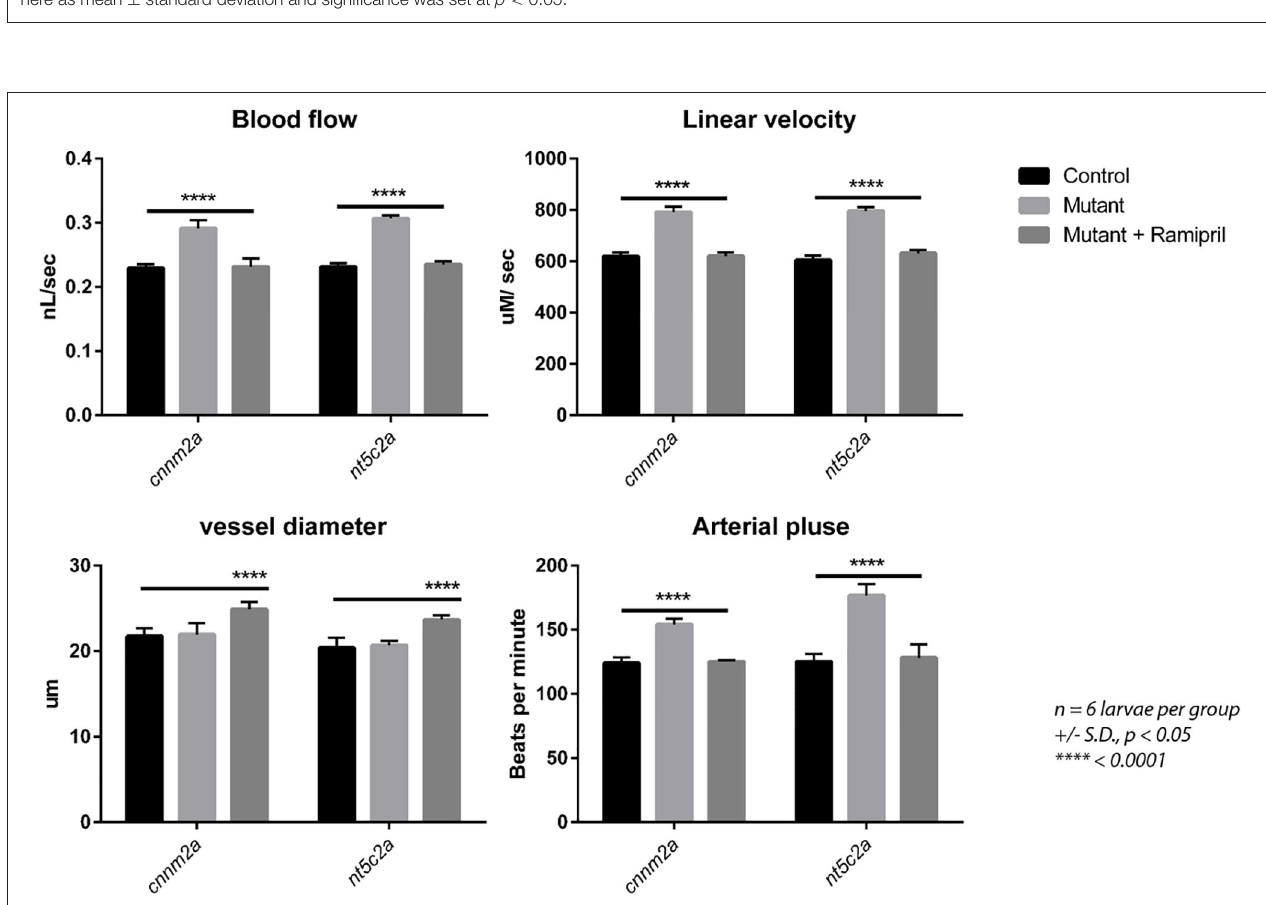
FIGURE 6 | Blood flow parameters measured with and without Ramipril treatments from cnnm2a and nt5c2a mutant zebrafish larvae along with ab-wildtypes as control. Blood flow (nL/sec), arterial pulse (beats per minute), vessel diameter ( µ m) and linear velocity ( µ M/sec) were measured from n = 6 larvae per group and presented here as mean with standard deviation as error bars and significance was set at p <